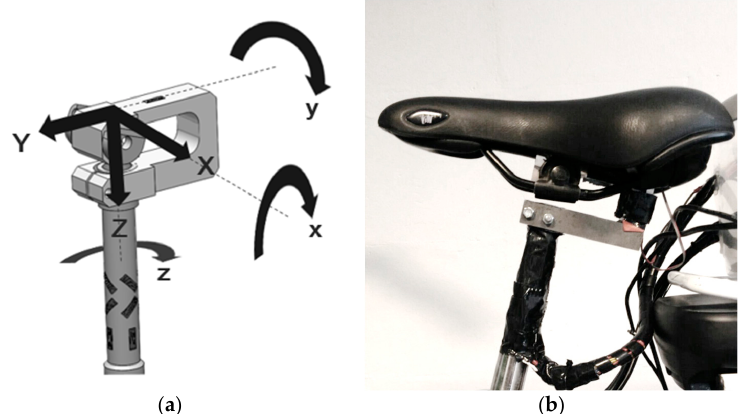
Table 1. Seat post loading during cycling.